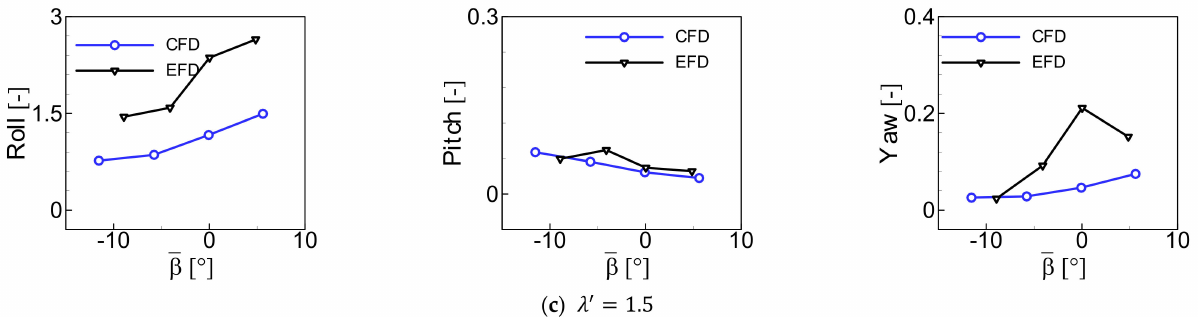
Figure 13. Motion RAOs versus the mean oblique angle in beam waves.